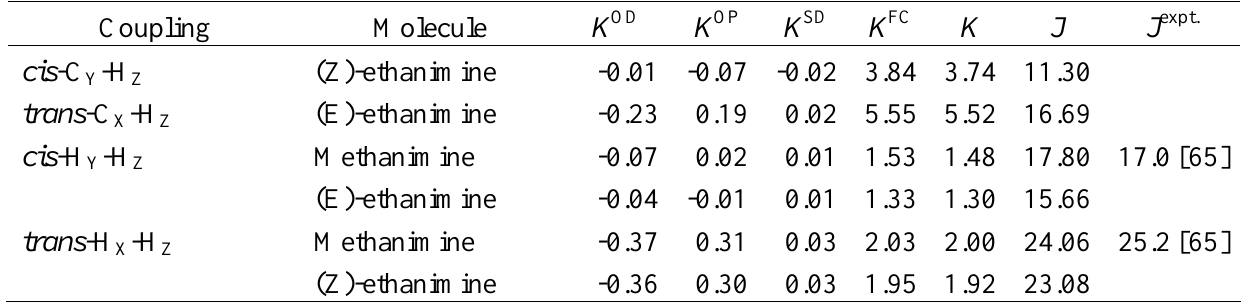
Table 4. Three-bond (vicinal) spin-spin couplings calculated at SOPPA(CCSD) level. Coupling constants, J , in Hz and reduced coupling constants, K , in 10 19 T 2 J -1